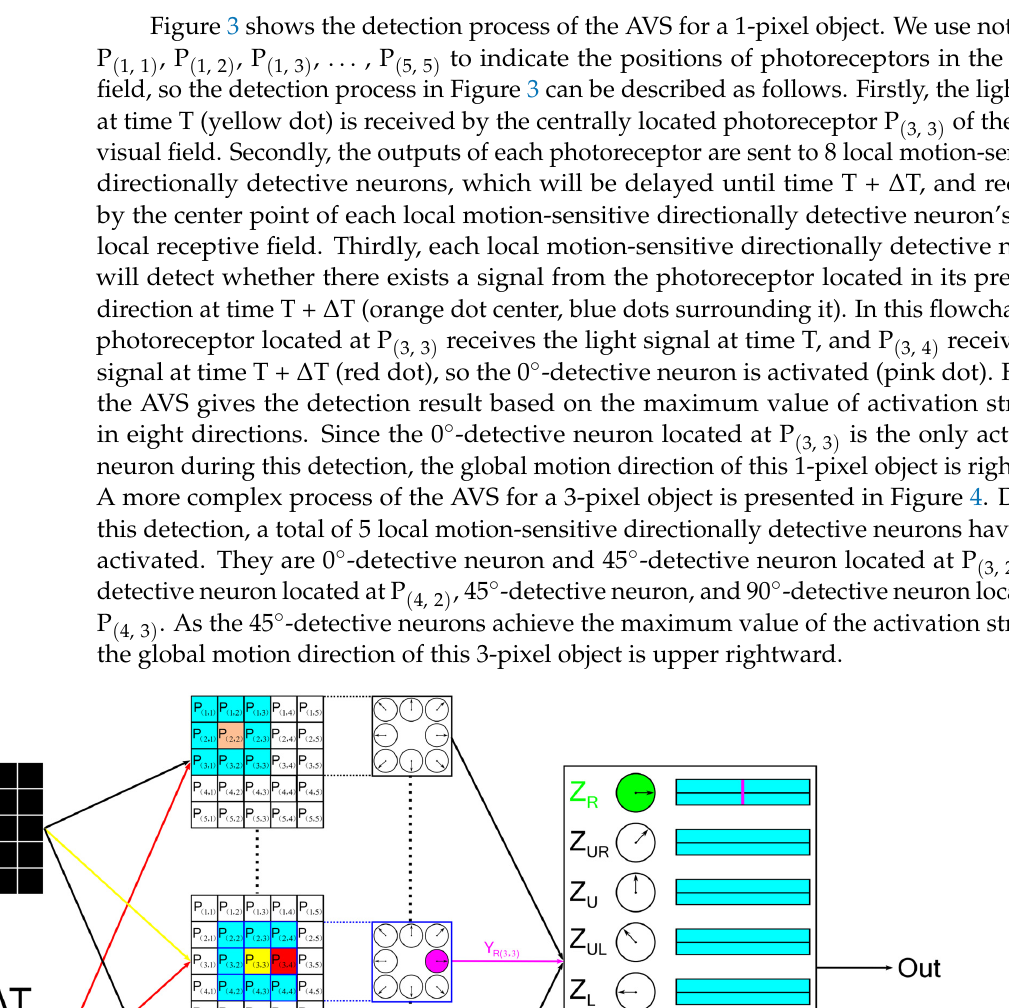
Figure 4. Flowchart of the AVS in detecting 3-pixel object.